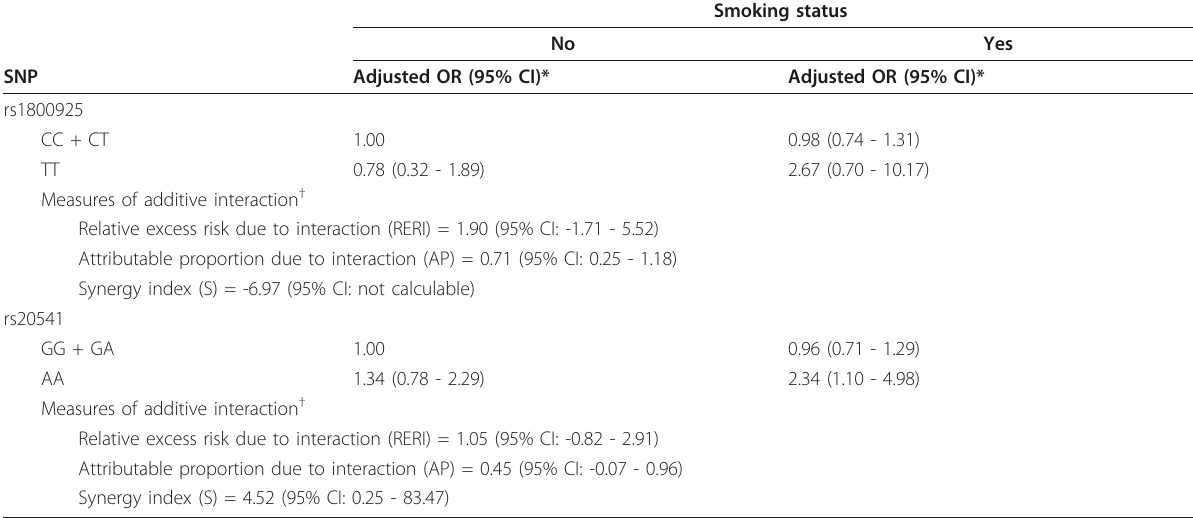
Table 6 Additive interaction between IL13 polymorphisms and smoking